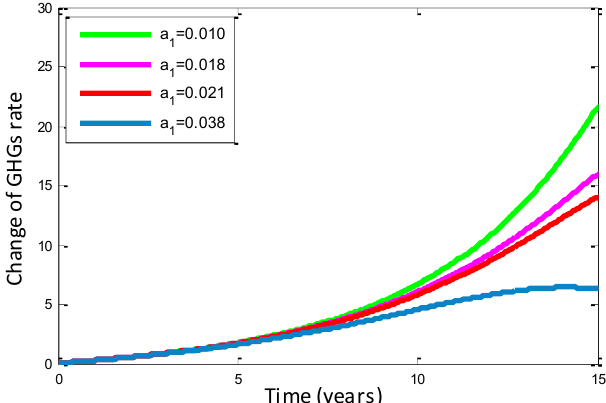
Figure 7 . The decreasing rate of GHGs at different values of 1 a .